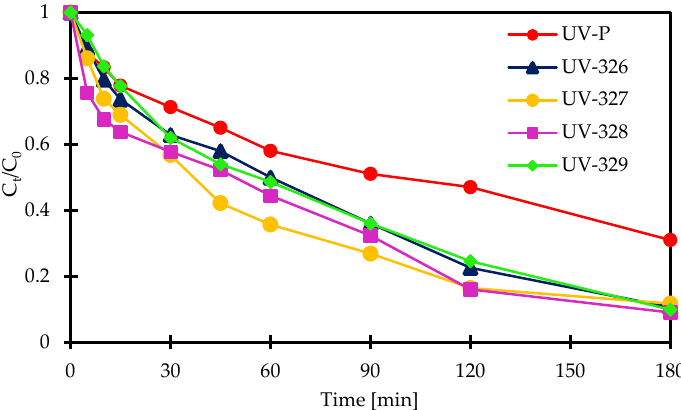
Figure 4. Kinetics of BUVs’s degradation in Fe 2+ /PAA process. Reaction conditions: [PAA] 0 = 25